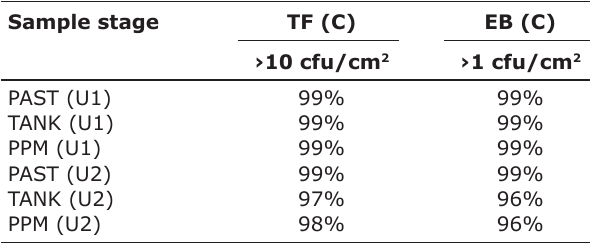
Table-2: Evaluation of the efficiency of the cleaning and disinfection protocol in both units. Sample stage